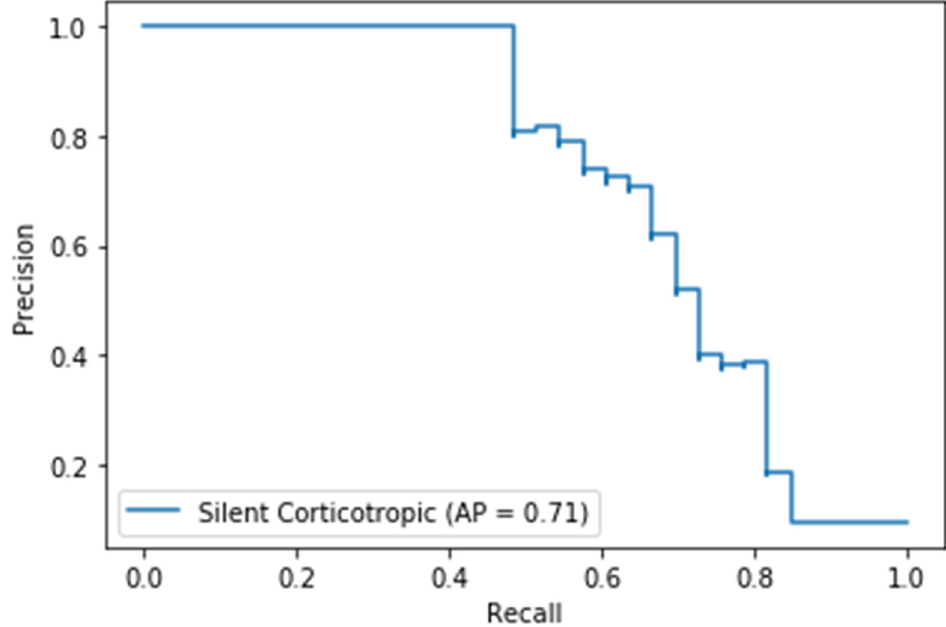
Figure 10. Results|Precision-recall curve for the class silent corticotropic adenoma of the models from the 5-fold cross-validation, which were trained on the unevenly distributed training set, in which silent-corticotroph adenoma made up only 9.7% of the tiles.